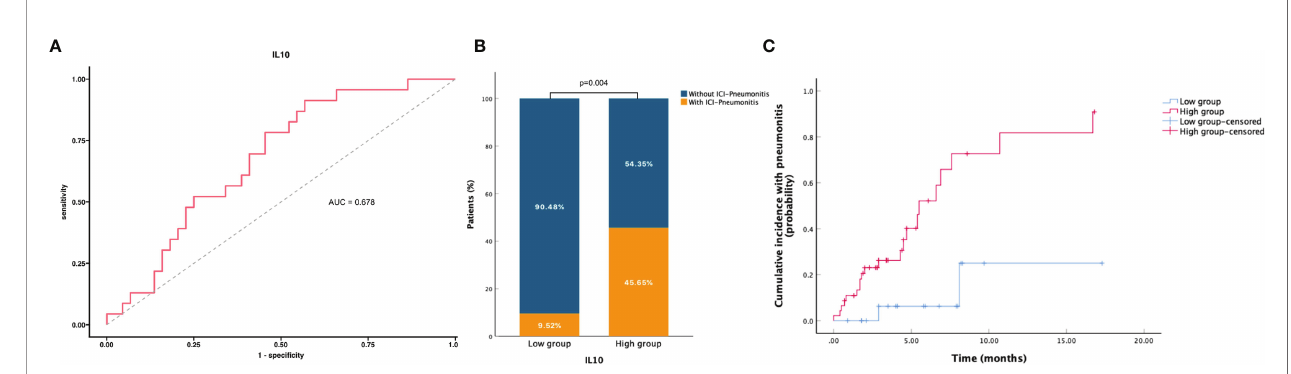
FIGURE 5 | Association between baseline blood IL-10 and ICI pneumonitis. (A) ROC curve analysis of IL-10 and ICI pneumonitis, AUC = 0.678. (B) The probability of ICI pneumonitis in patients with high IL-10 and low IL-10. (C) Accumulative incidence of ICI pneumonitis among patients during ICI therapy. Patients who were lost to follow-up or died were de fi ned as censored value. ICI-pneumonitis, immune checkpoint inhibitor-related pneumonitis; ROC, receiver operating characteristic; AUC, area under the curve.